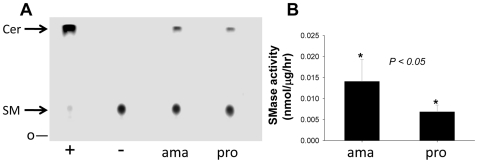
Detection of neutral SMase activity in L. amazonensis promastigotes and axenic amastigotes.Whole cell lysate from L. amazonensis promastigotes (pro) and axenic amastigotes (ama) were incubated with NBD-labeled C6 sphingomyelin and neutral SMase activity was determined by TLC (A) and normalized to nmol/µg/hour (B). Positive control (+): 0.1 unit of B. cereus SMase; negative control (−): boiled L. major WT lysate. Experiments were repeated multiple times and error bars represent standard deviations. *, p<0.05.